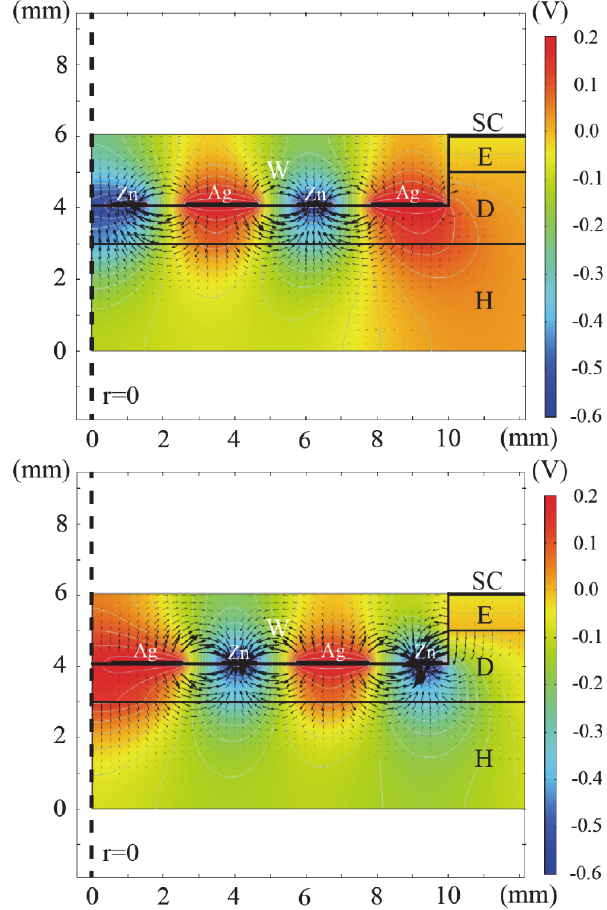
Fig.5: The electric field in the wound area with a wound dressing Procellera ® applied with Ag/Zn closest to the wound edge ( top/bottom ). The reddish dots are Ag and the blue ones represent Zn. The potential difference between the dots gives rise to an electric field strength that is much larger than that from the body's own field. Notice that when Zn is closest to the wound edge (bottom) there are large electric fields set up with large potential for influencing what happens on a microscopic scale when it comes to cell migration cued by the electric field. Notice that the electric field is not shown in the plane between the dots since it is too